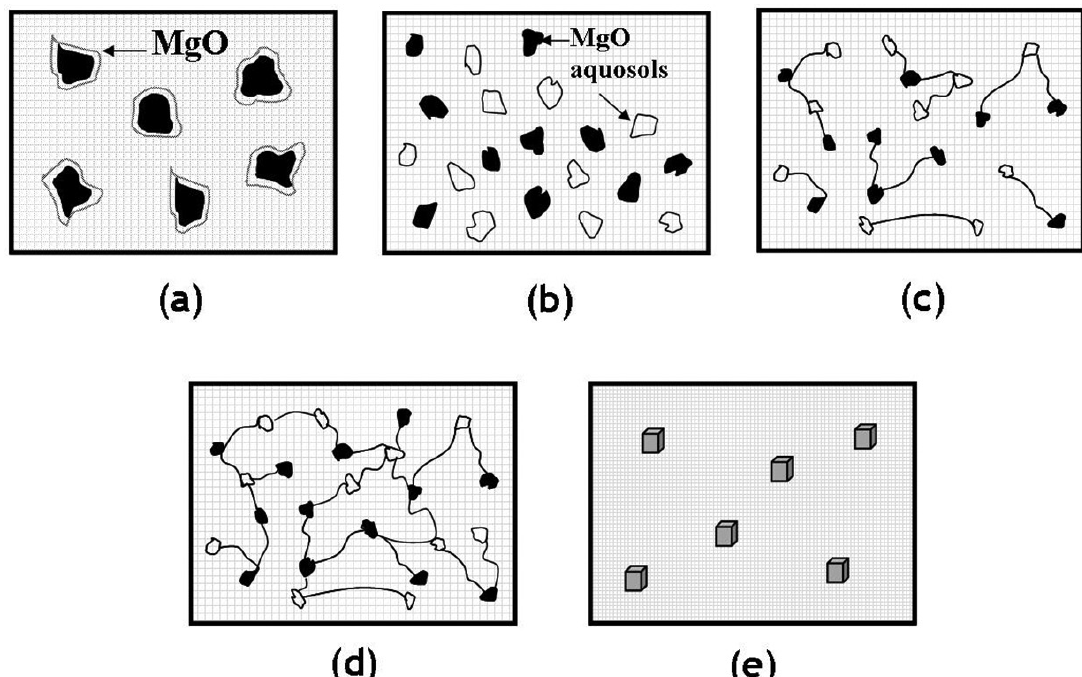
Figure 1. Pictorial representation of the formation of CBPCs: (a) Dissolution of oxides (b) formation of aquosols (c) acid-base reaction and condensation (d) percolation and formation of gel (e) crystallization and saturation of gel into a ceramic 2